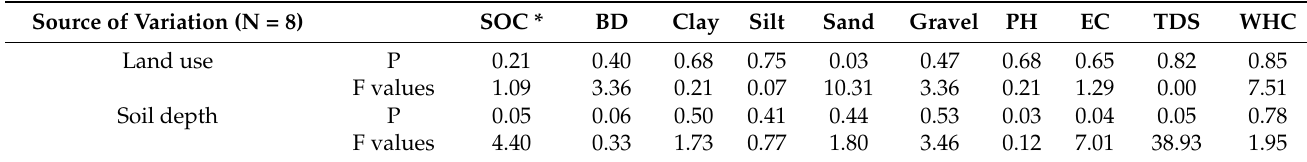
Table 2. Results of t-test for the selected soil properties (statistical significance at p < 0.05). Source of Variation (N =